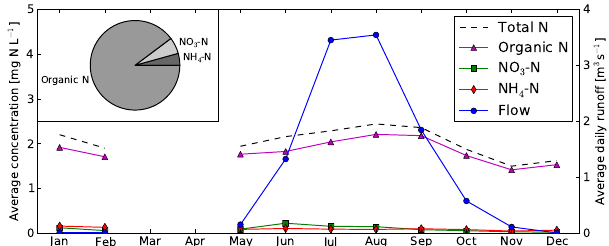
Fig. 1. Seasonal cycle and relative contribution of different species to TN (pie chart) in the Ellen Brook (1989–2006). Missing values in March and April correspond to no flow